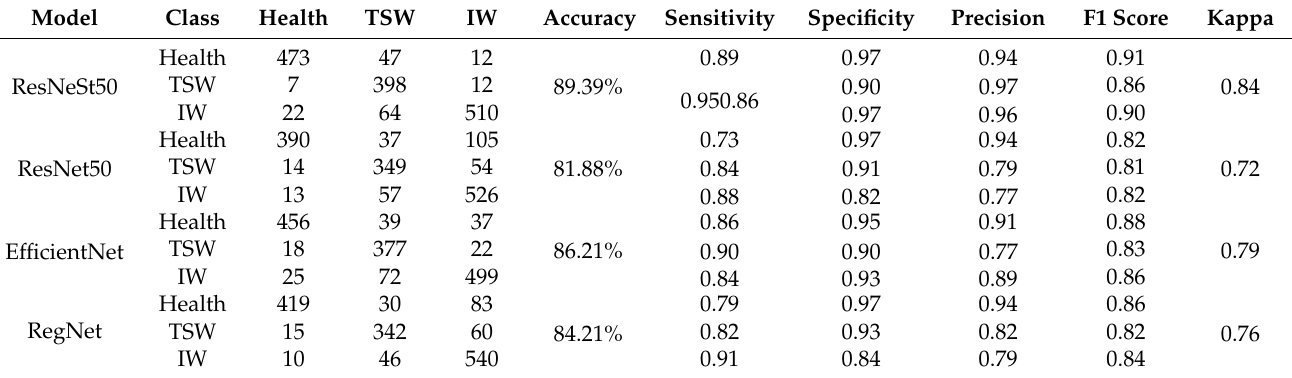
Table 4. Test results—based on images at the heading stage.